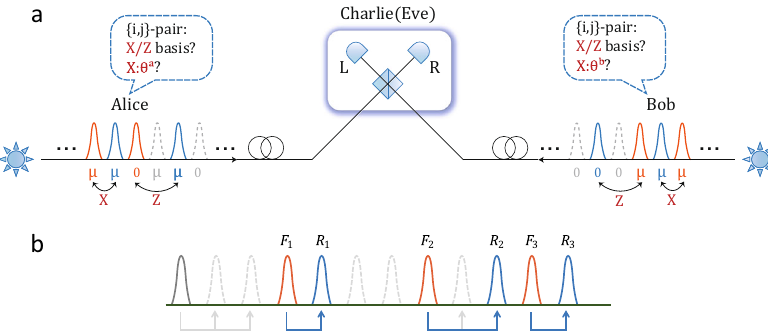
Fig. 2 Schematic diagram of the mode-pairing MDI-QKD scheme and the simple pairing strategy with maximal-pairing interval l . The solid and dashed pulses are those with and without successful detection, respectively. Orange and blue pulses are, respectively, the front and rear pulses that succeed in pairing within l pulses, while grey pulses are the ones fail in pairing. a In the mode-pairing MDI-QKD scheme, Alice and Bob, fi rst prepare coherent pulses with random intensities chosen from {0, μ } and random phases ϕ a ð b Þ i 2 ½ 0 ; 2 π Þ and send them to Charlie. After interference measurement, Charlie announces the detection results, based on which Alice and Bob pair the pulses and determine their encoding bases. For X -pairs, they announce the alignment angles θ a and θ b and keep data for which θ a = θ b . They use Z -pairs to generate keys and other data for parameter estimation. b We set l = 2 in the simple pairing strategy for example. The labels F k and R k represent the front and rear pulses, respectively, in the k -th successful